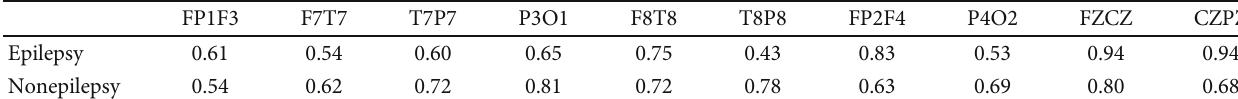
Table 4: Signi fi cance analysis of sample entropy before and after